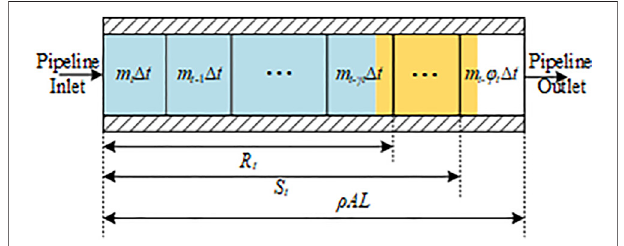
FIGURE 2 | Flow schematic diagram of pipeline in heating